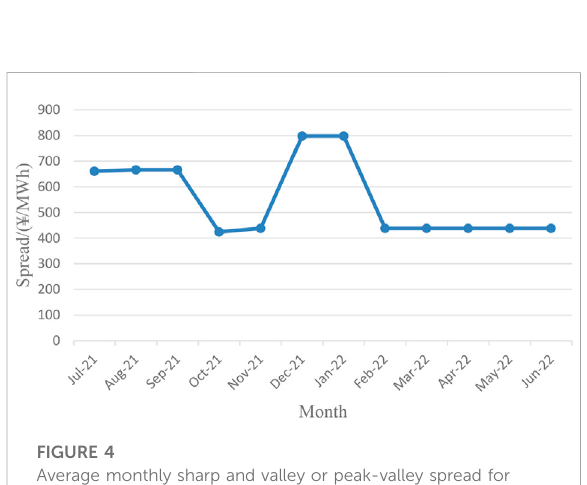
FIGURE 4 Average monthly sharp and valley or peak-valley spread for the province from July 2021 to June